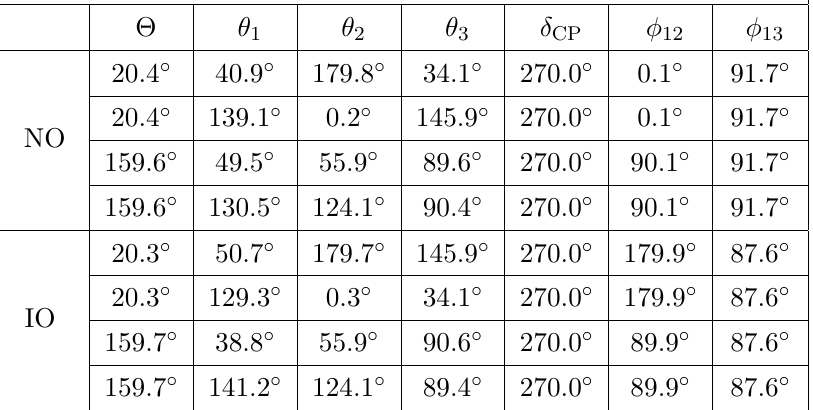
Table 2 . Numerical examples for the generalized e (cid:0) (cid:28) re(cid:13)ection, assuming (cid:11) = (cid:13) = 0. The values of (cid:2) and (cid:18) 1 ; 2 ; 3 are determined from the best (cid:12)t values of neutrino mixing angles including (cid:14) CP = 3 (cid:25)= 2 [6, 7]. Notice that the two Majorana CP phases are predicted , as shown in the table. we have